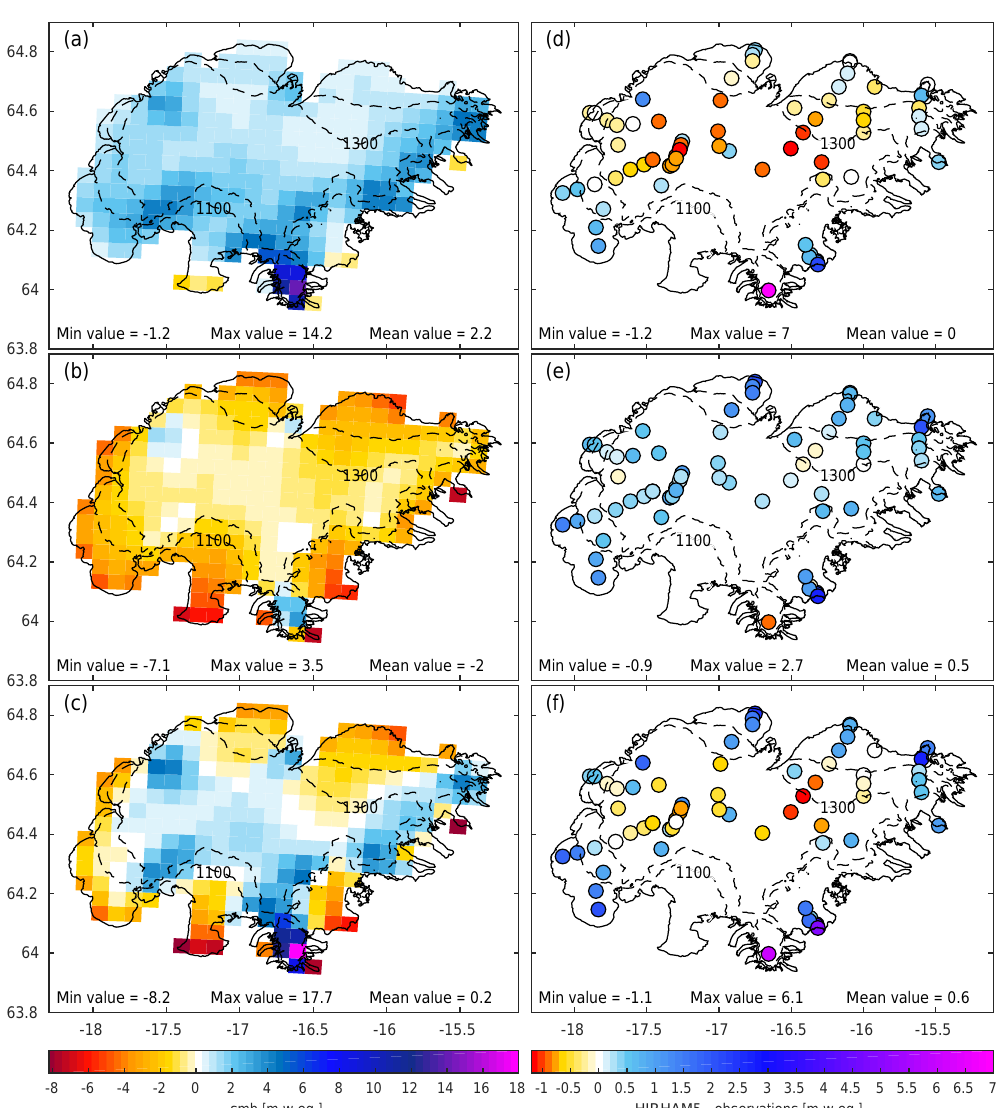
Figure 9. The average (a) winter, (b) summer, and (c) net SMB simulated by HIRHAM5 from the 1980–1981 glaciological year to 2013– 2014. The contour lines marks the approximate location of the ELA, which generally lies between approximately 1100 and 1300m elevation. Panels (d) – (f) show the average deviation between model and observations over the observation period (1992–2014) for each measurement location for the (d) winter, (e) summer, and (f) whole glaciological